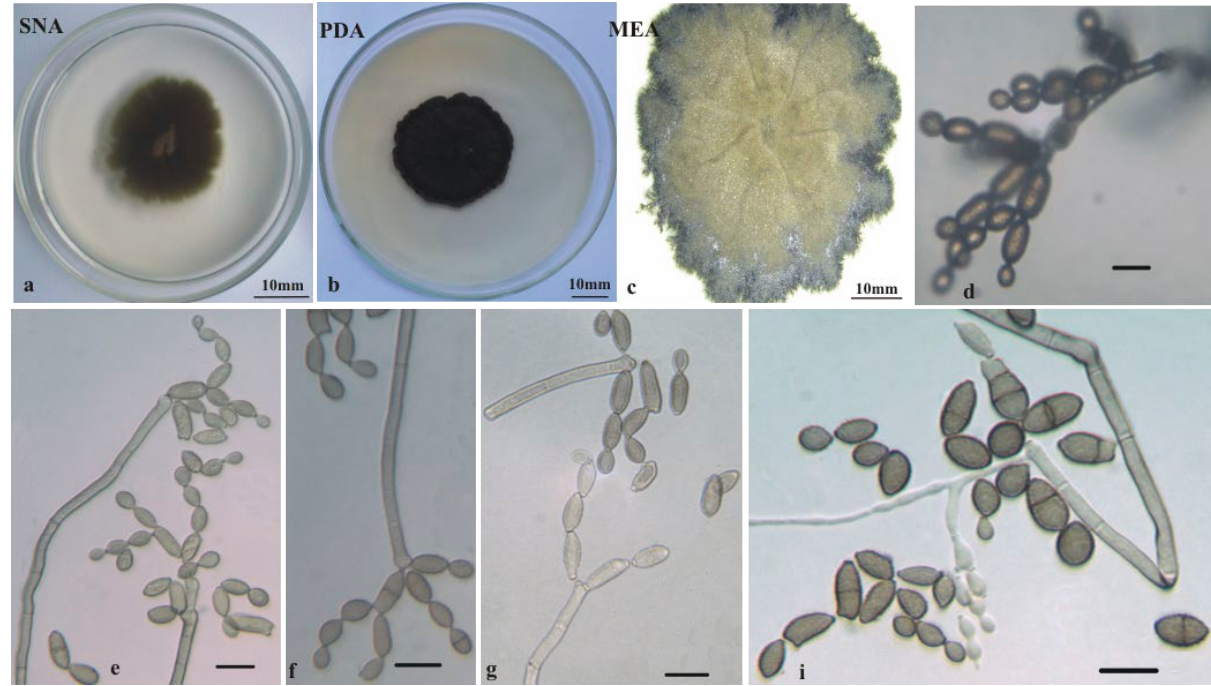
Figure 2. Cladosporium macrocarpum : (a) Colony on SNA, (b) colony on PDA, (c) colony on MEA. (d) Conidial chain. (e, f) Ma- cronematous conidiophores and conidia. (g, h) Macro- and micronematous conidiophores and conidia. Scale bar = 10